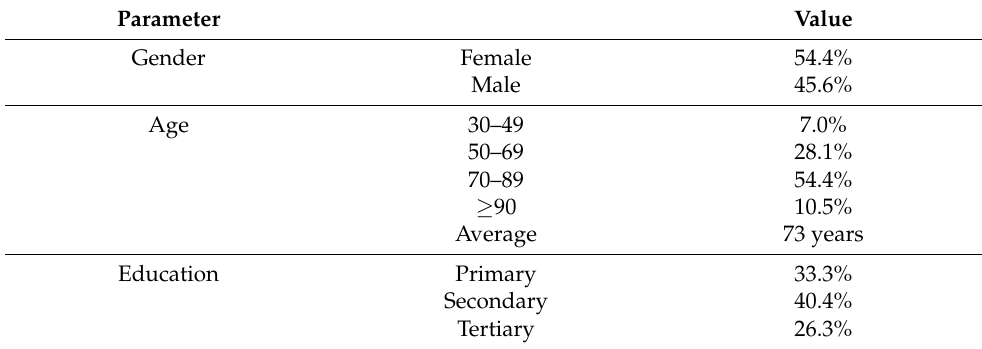
Table 1. Demographic characteristics (respondents =